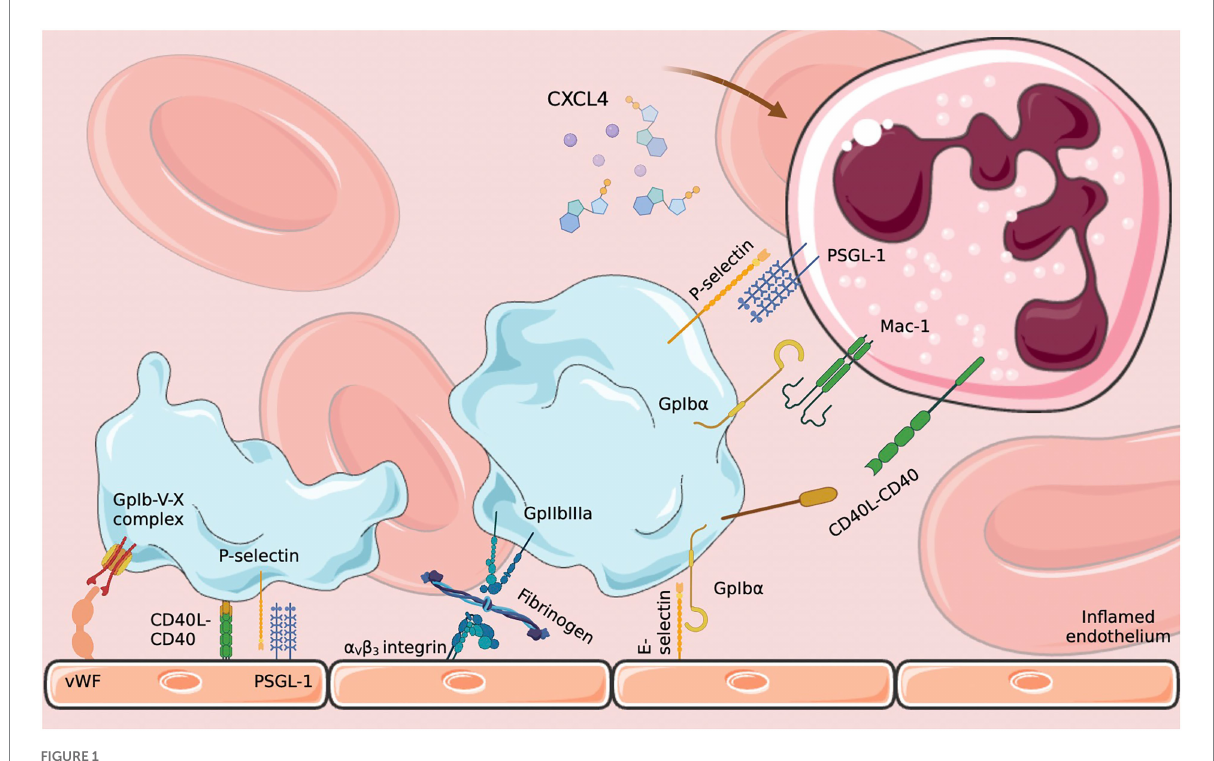
FIGURE 1 Platelet–endothelium and platelet–neutrophil interactions. Endothelial activation in response to infection induces platelet activation which in turn activates neutrophils through various signaling pathways. CXCL4: platelet factor 4; PSGL-1: P-selectin glycoprotein 1; E-selectin: endothelial selectin. Diagram created on biorender.com using SMART (Servier Medical Art)